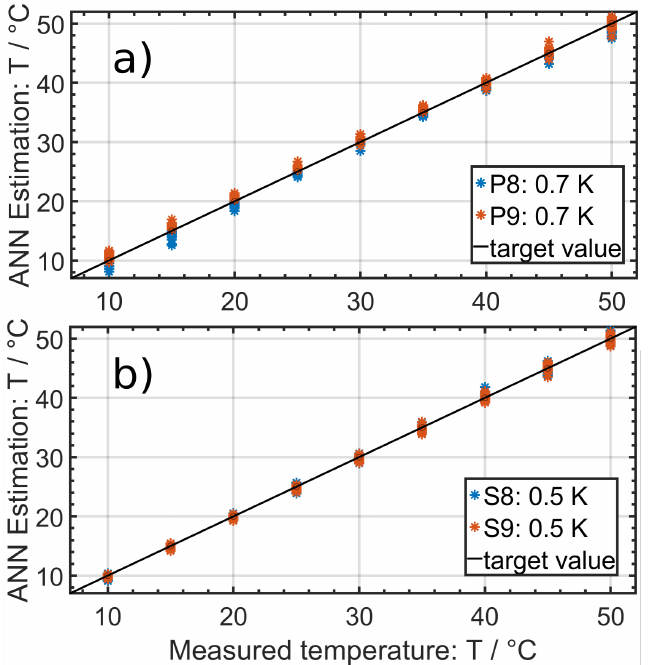
Figure 9. Temperature estimations for ( a ) Panasonic NCA 103450 with an RMSE of 0.7 K, and ( b ) Sony US18650VTC6 with an RMSE of 0.5 K. In both figures, 360 temperature estimations are shown. The estimated temperature is plotted over the measured temperature. The black line is a guide to the eye of the target values. The legend shows the RMSE for each